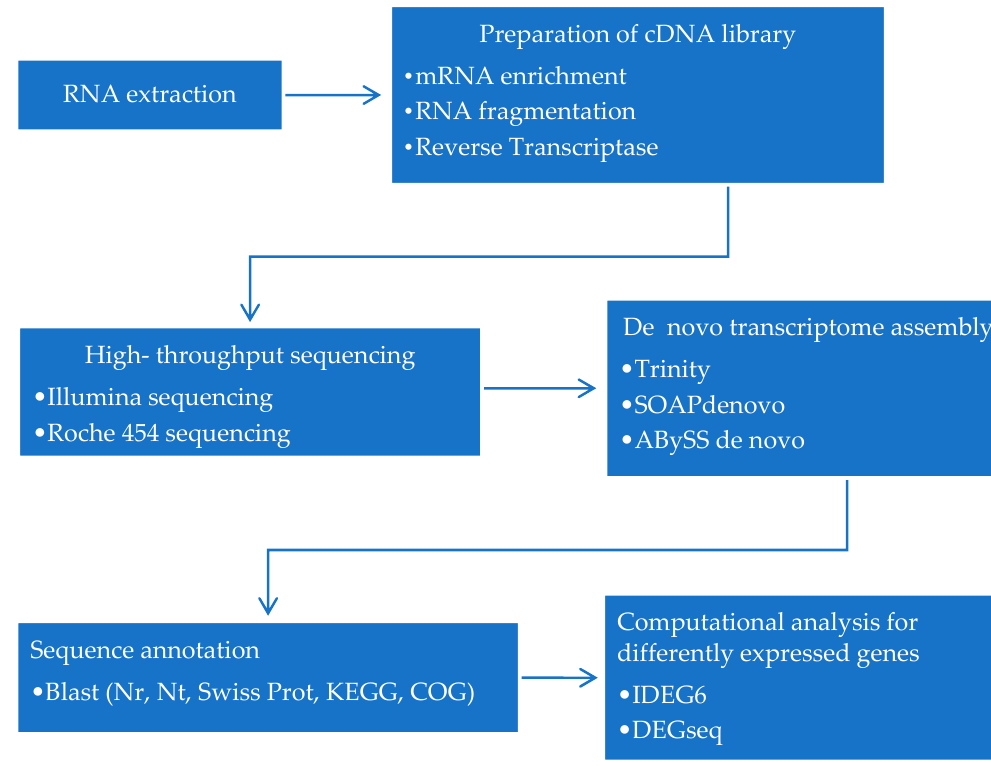
Figure 1. Current strategies and workflow for dinoflagellates transcriptomics study. Following RNA extraction, cDNA library will be generated and then will be sequenced using NGS platform. Then, the generated reads will be assembled and annotated before computational analysis can be done.